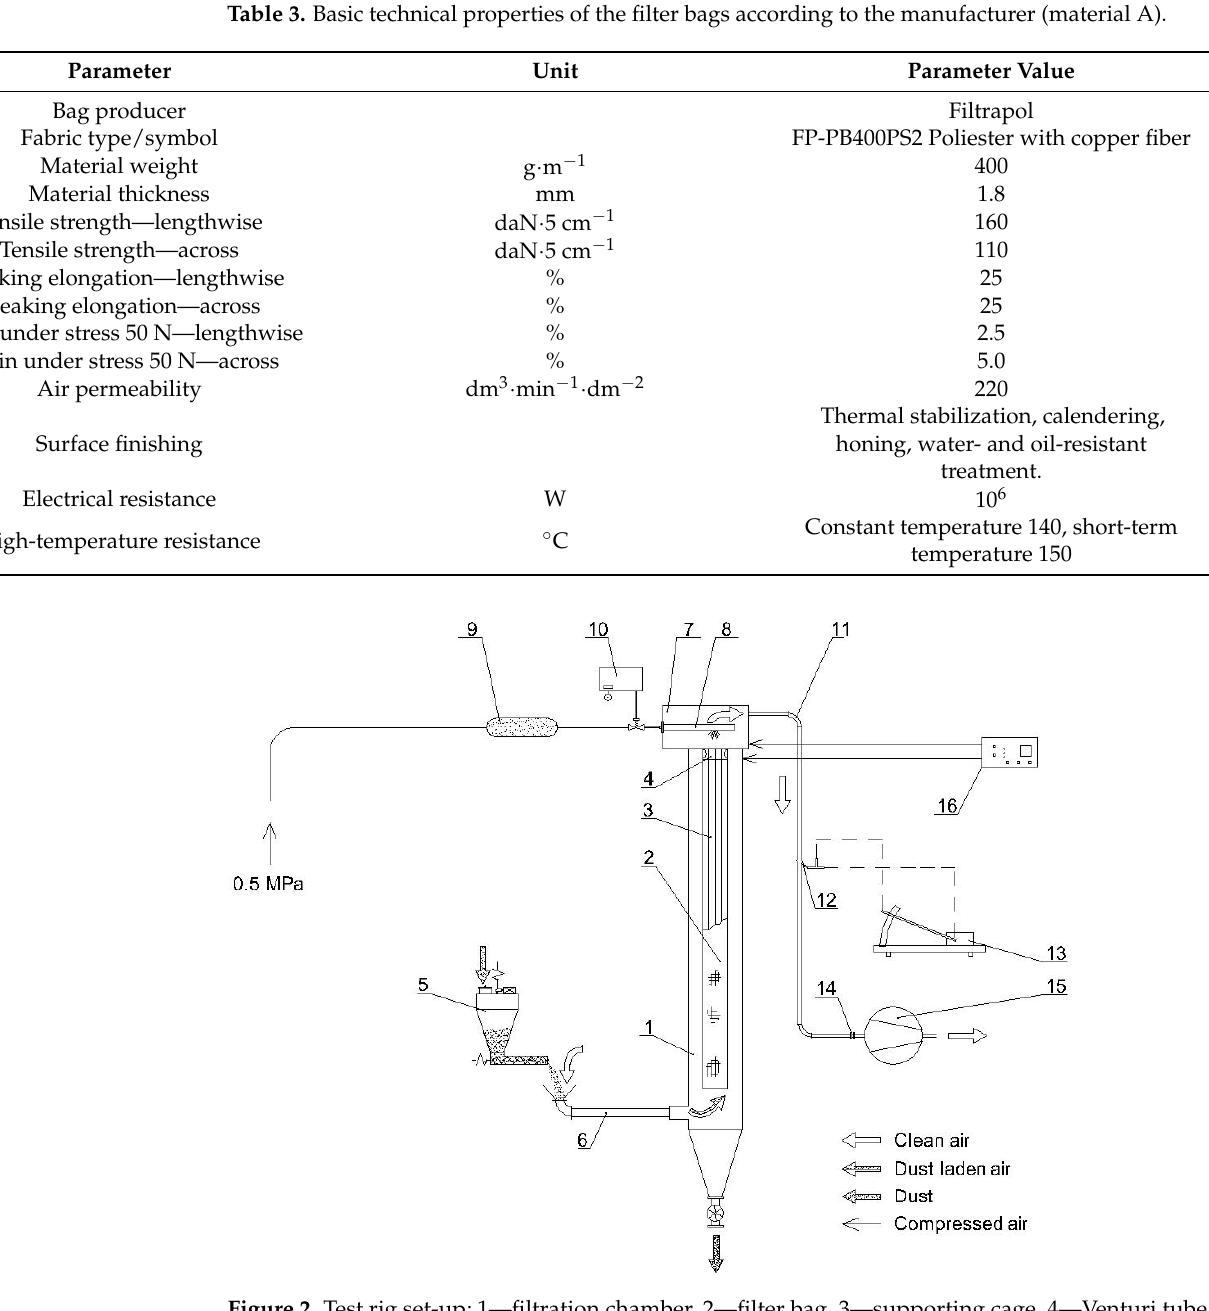
Figure 2. Test rig set-up; 1 — filtration chamber, 2 — filter bag, 3 — supporting cage, 4 — Venturi tube,